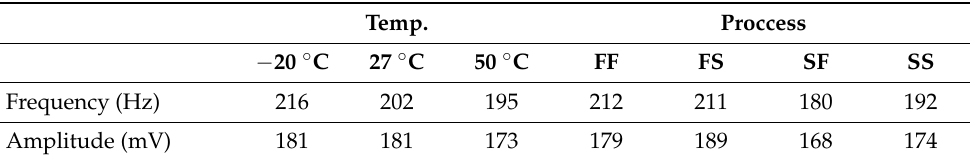
Table 2. Temperature and process corners analysis.